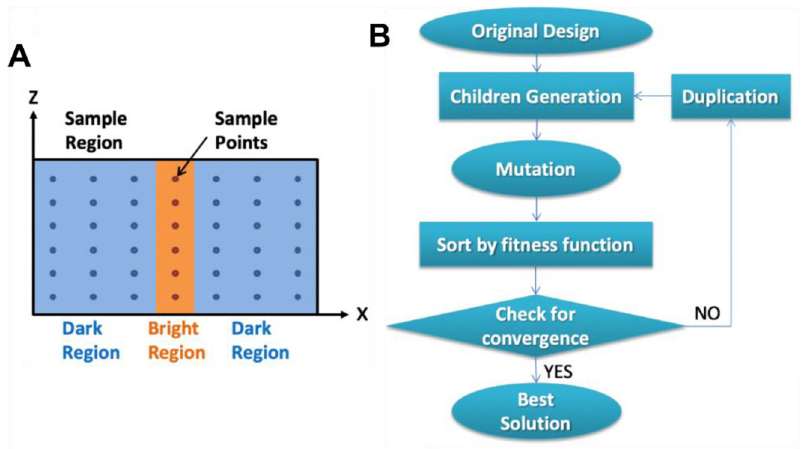
Figure 1: The targeted light sheet mode and sampling with an array of equi-spaced points inside (Bright Region) and outside (Dark Region) the light-sheet pattern (A); Flow chartof GAincludesinitializationof an originalgeneration,applicationofmutation to the current generation, sorting the children generation according to their scores graded by fitness function,